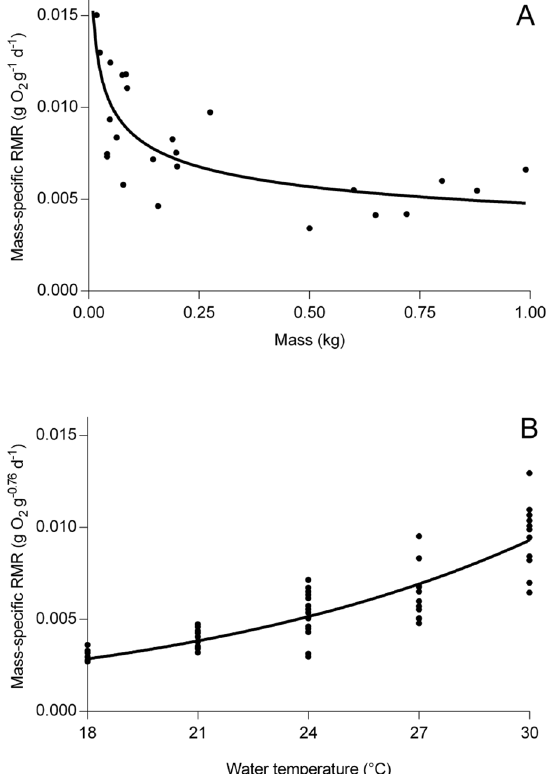
Figure 1. ( A ) Mass-specific resting metabolic rate (RMR) of tailor (n = 24) with increasing fish mass, at 24 °C. A linear regression of these data with both axes logged defines the parameter R A (the intercept) and parameter R B (the slope) from equation (3) (Table 2). ( B ) Mass-specific resting metabolic rate (RMR) of tailor (n = 12 per treatment) with increasing water temperature. The slope of logged values is the parameter RQ (equation